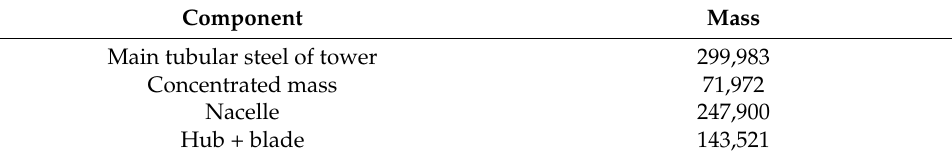
Table 3. Mass of tower components (kg).